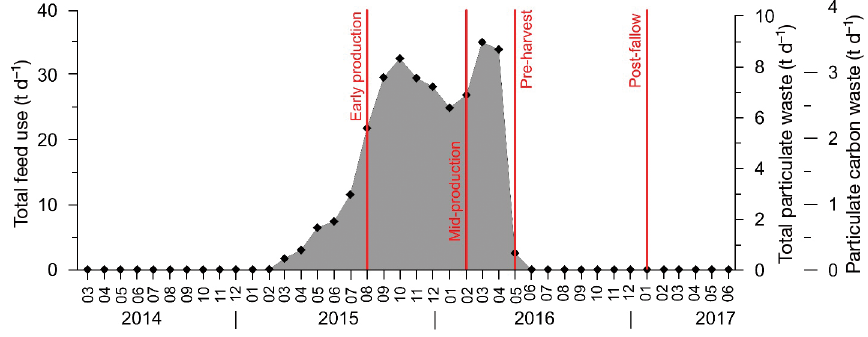
Fig. 2. Timeline of monthly feed use, total waste particulates dis- charged (assuming 25.6% as fe- ces and 6.4% as waste feed) and carbon discharged (38% in feces and 50% in waste feed;